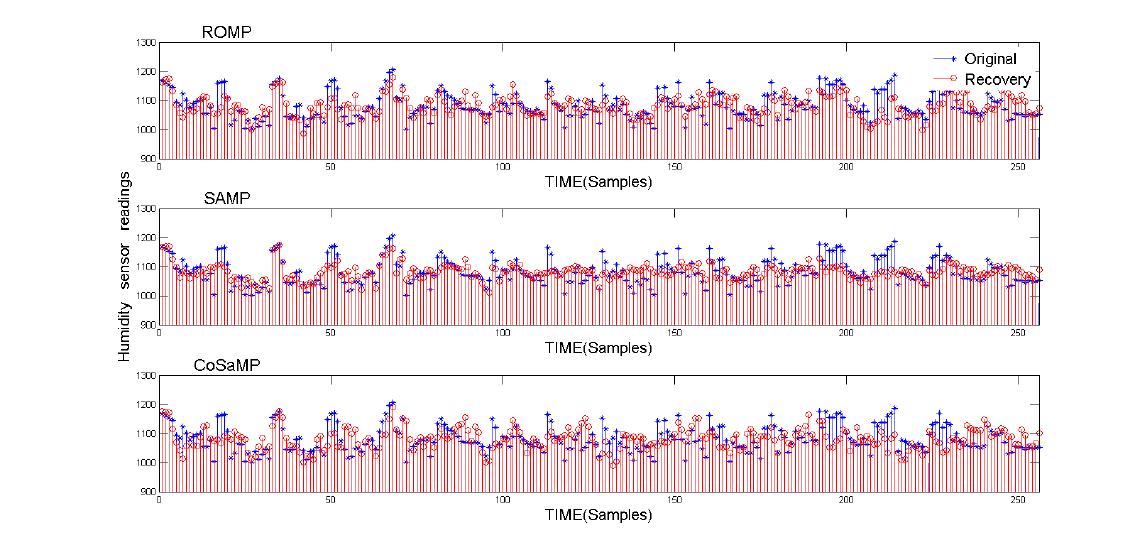
Figure 13. Reconstruction performance of three recovery